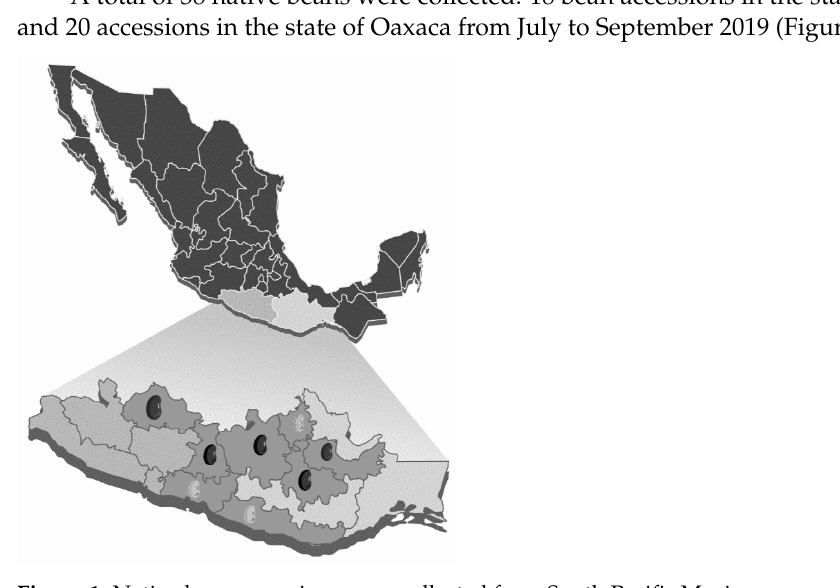
Figure 1. Native bean accessions were collected from South Pacific